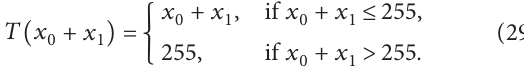
� [ T ( 􏽥 x + n ) , . . . , T ( 􏽥 x noise 1 1